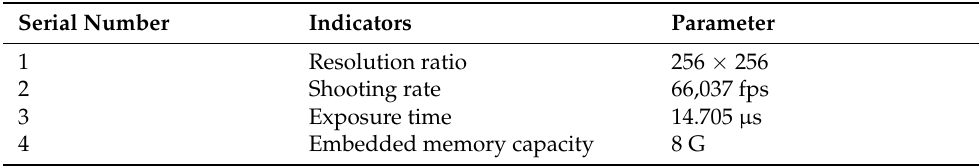
Table 1. Specific technical indexes of high-speed digital